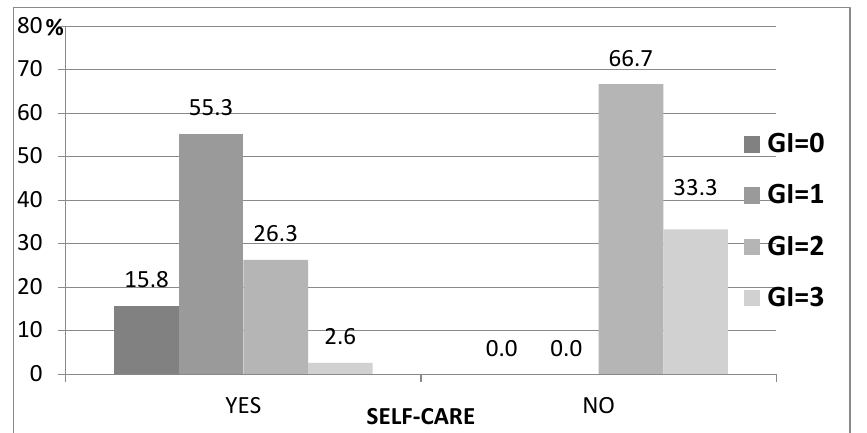
Figure 5. Relationship between GI and self-care.